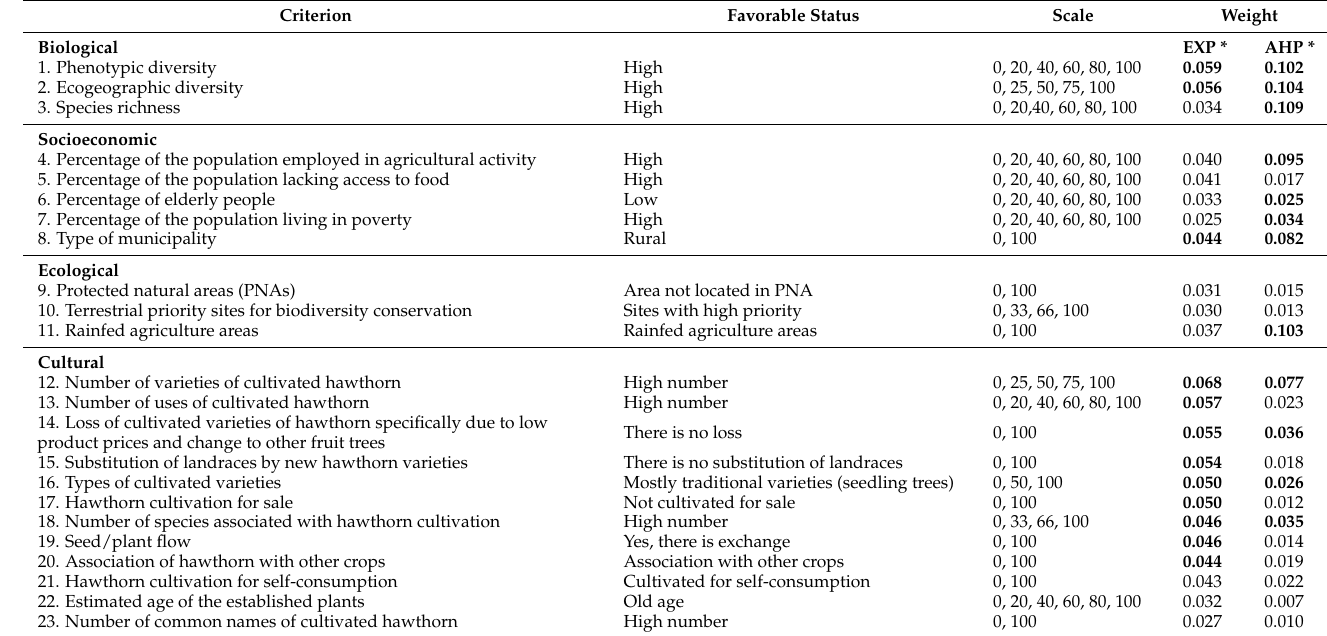
Table 2. Favorable status, final values, and weight of the important criteria for the identification of priority areas for the in situ conservation of cultivated hawthorn ( C. mexicana ) obtained by experts (EXP) and analytic hierarchy process